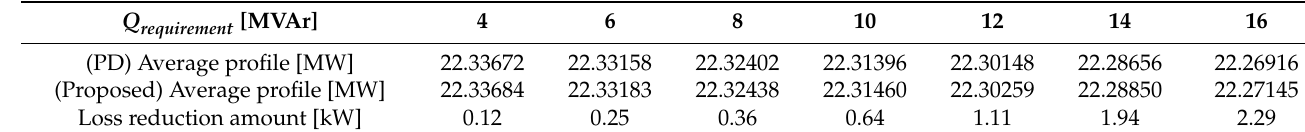
Table 3. Average real power profiles and reduced power loss.